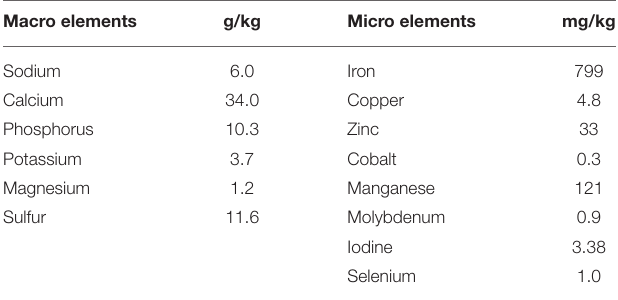
TABLE 4 | The content of mineral elements in Agro-Matic protein concentrate. Macro